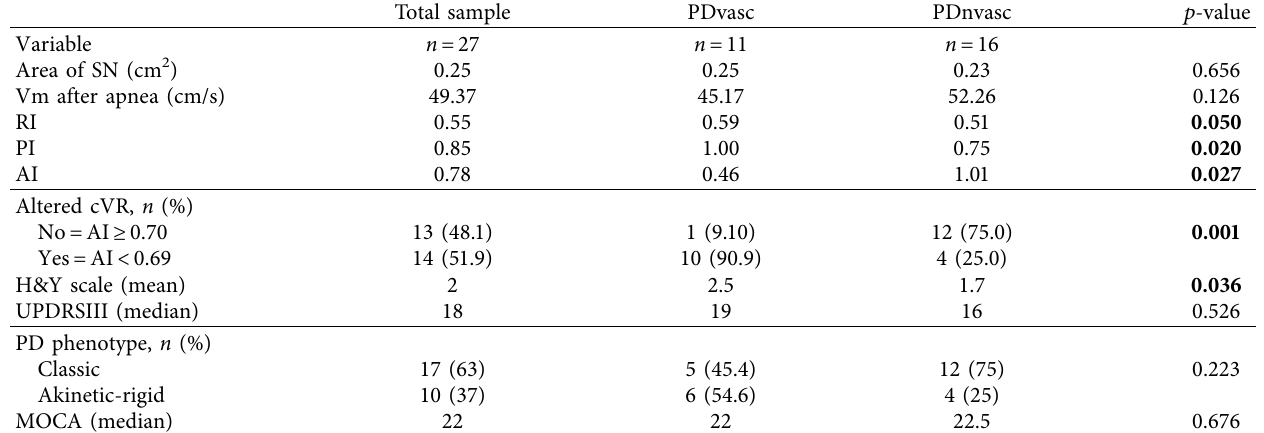
Table 2: Comparison of ultrasound characteristics between the groups (PDvasc x PDnvasc). Total sample